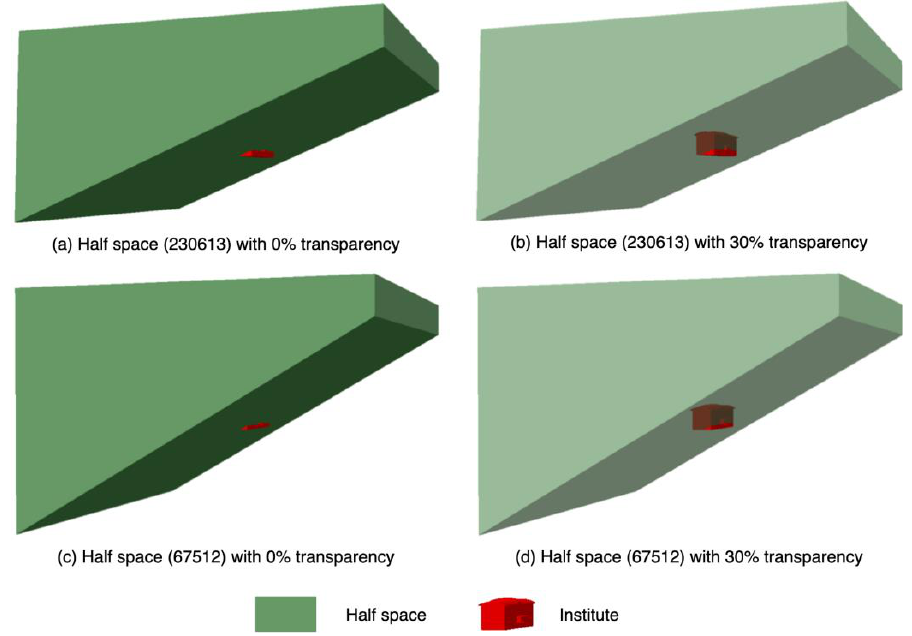
Figure 9. Examples of half spaces. ( a ) Half space (230613) with 0% transparency; ( b ) half space (230613) with 30% transparency; ( c ) half space (67512) with 0% transparency; and ( d ) half space (67512) with 30% transparency.